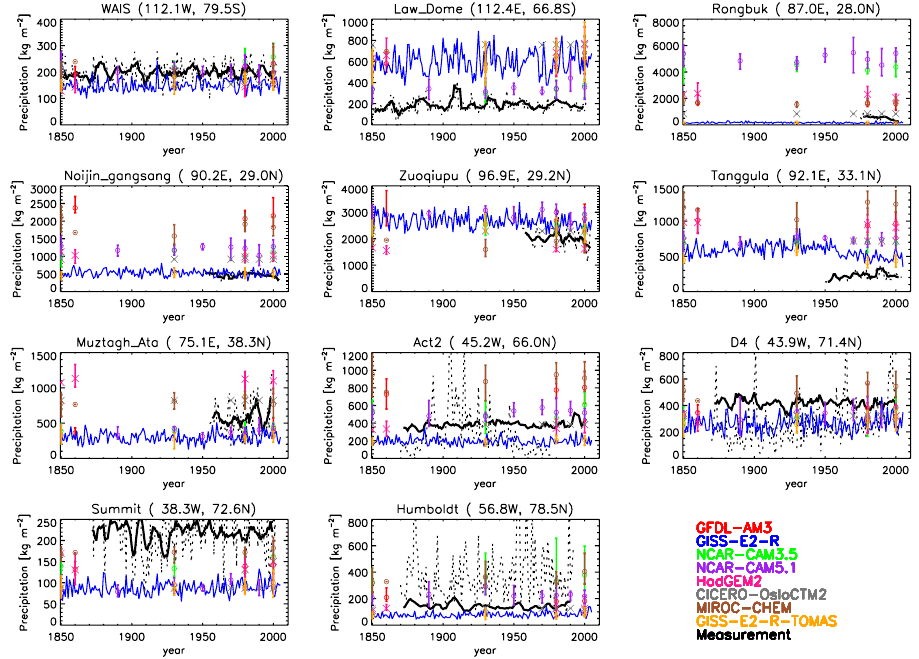
Fig. 13. Same as Fig. 11 but for annually accumulated precipitation [kgm − 2 ]. The observed precipitation shown here is computed based on the observed BC deposition fluxes divided by the observed BC snow concentration. Note that the ACCMIP timeslice simulations for NCAR-CAM3.5 and MIROC-CHEM are used.